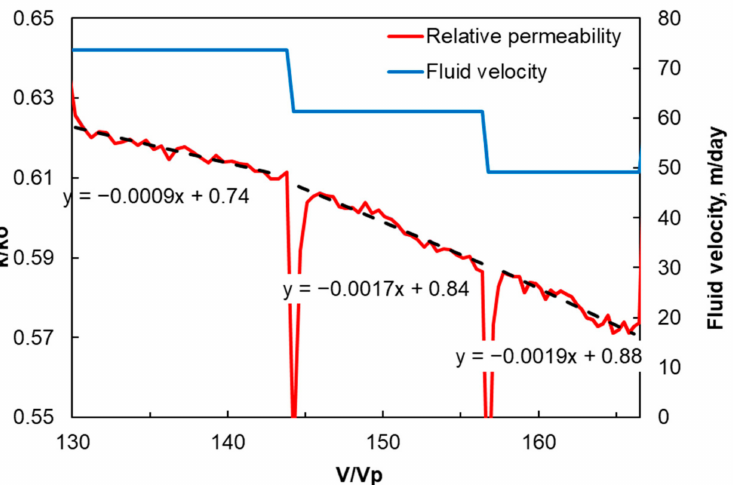
Figure 5. Change in relative permeability of sample IEKEV5602 during deionized water injection. Dashed black lines show linear approximations with equations. The slope of the permeability curve at high fluid velocity is less than at lower fluid velocities, this can be seen from the linear function coefficient, the greater the absolute value of the coefficient, the more intensively the permeability